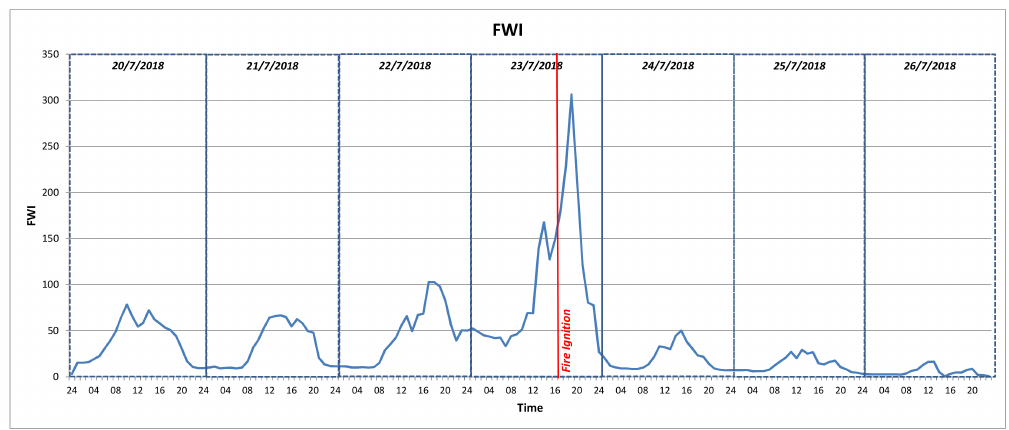
Figure 19. Fire Weather Index for the Mati-Rafina fire incident in Greece (23/7/2018) extracted based on environmental condition measurements obtained by local weather stations.